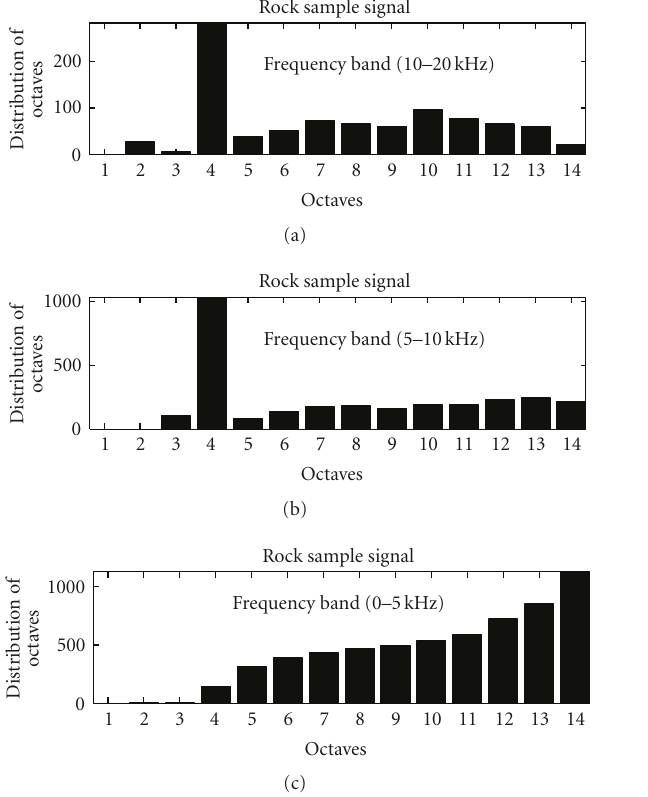
Figure 10: Octave distribution over three frequency bands for a rock signal.